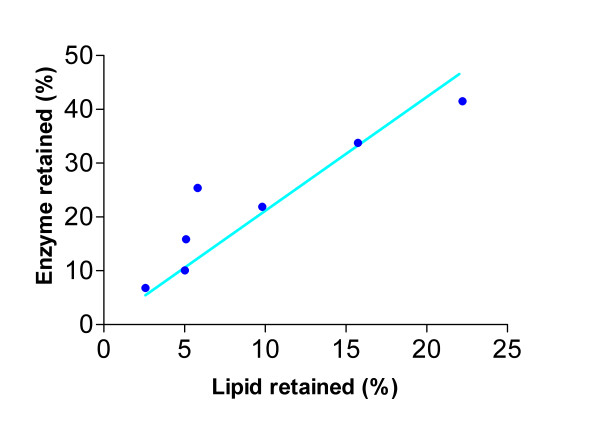
Relation between lipid and intravesicular marker retention. Liposomes labeled with rhod-PE and containing AChE were chromatographied on G25M. Fluorescence and activity were collected before and after addition of TX-100.